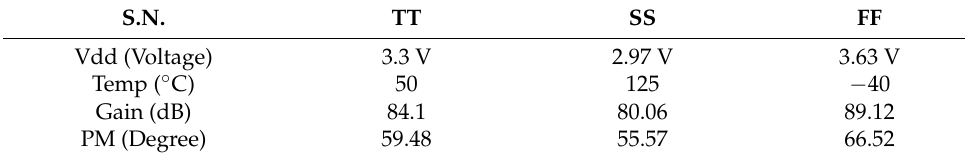
Table 3. Summary of the operational amplifier noise